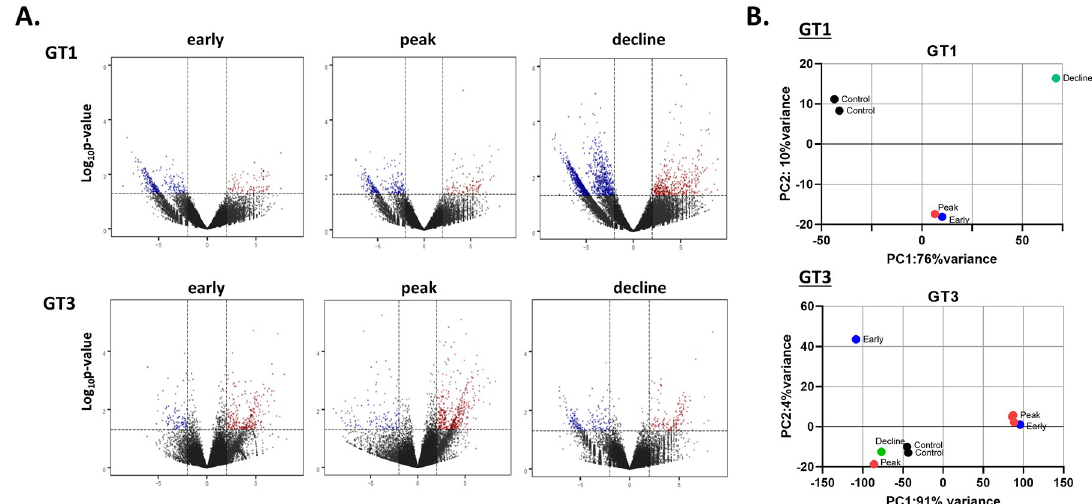
Fig 2. Identification of differentially expressed genes (DEGs) in the liver tissues of experimentally infected rhesus macaques with HEV gt1 or gt3 infections. (A), Volcano plot showing DEGs at early, peak, and decline phases of HEV gt1 and gt3 infections compared to two na ï ve control animals. Red-dot, upregulated genes; blue-dot, downregulated genes. (B), Principal component analysis (PCA) of each liver sample of HEV gt1 or gt3 infected animals and controls based on 33,372 unique DEGs identified at early, peak, decline and control samples.